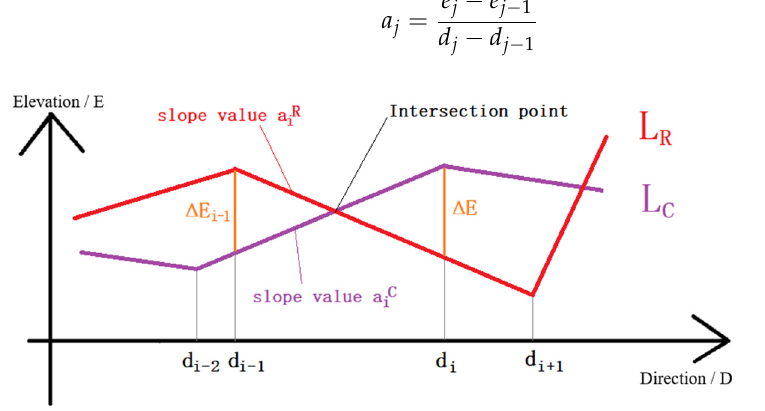
Figure 5. In the D-E coordinate system, by creating subsections and comparing the e value on the two polylines at the end of each subsection, the visibility of the corresponding terrain on line L C is determined.